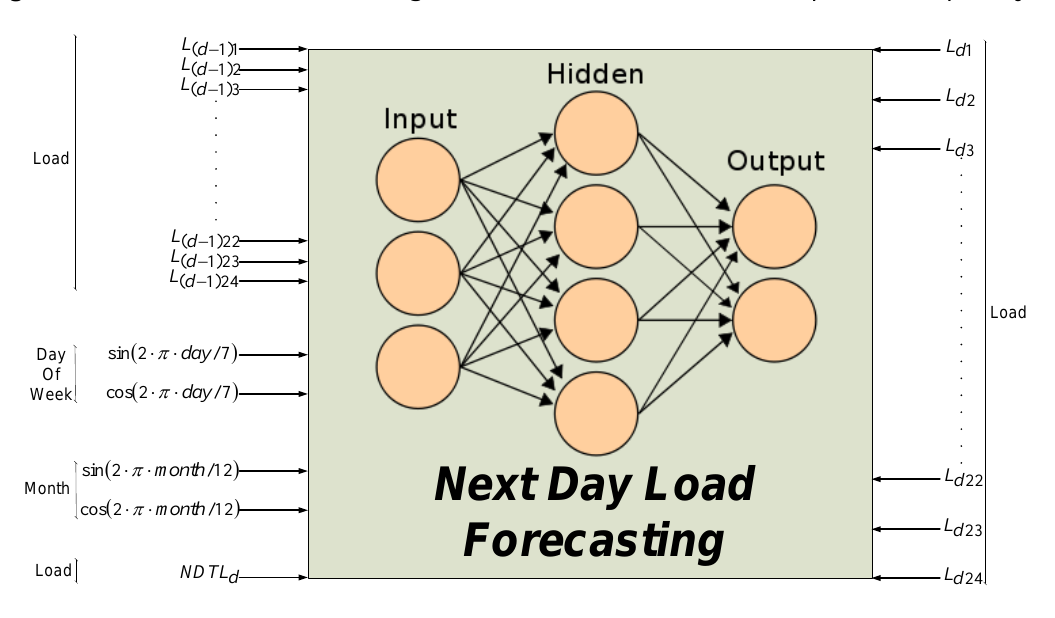
Figure 6. MLP architecture. The Figure shows the variables of the input and output layers.